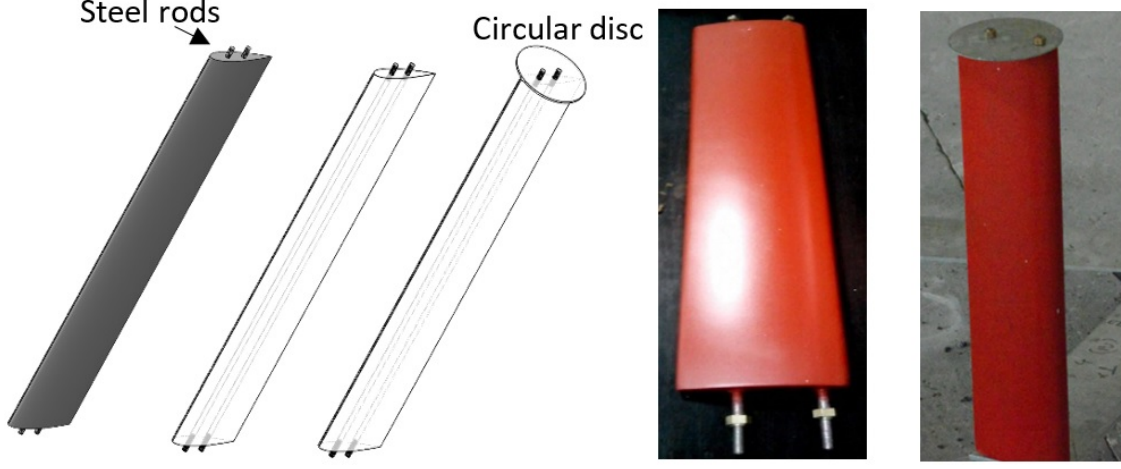
Figure 13. CAD drawings and pictures of turbine blades.